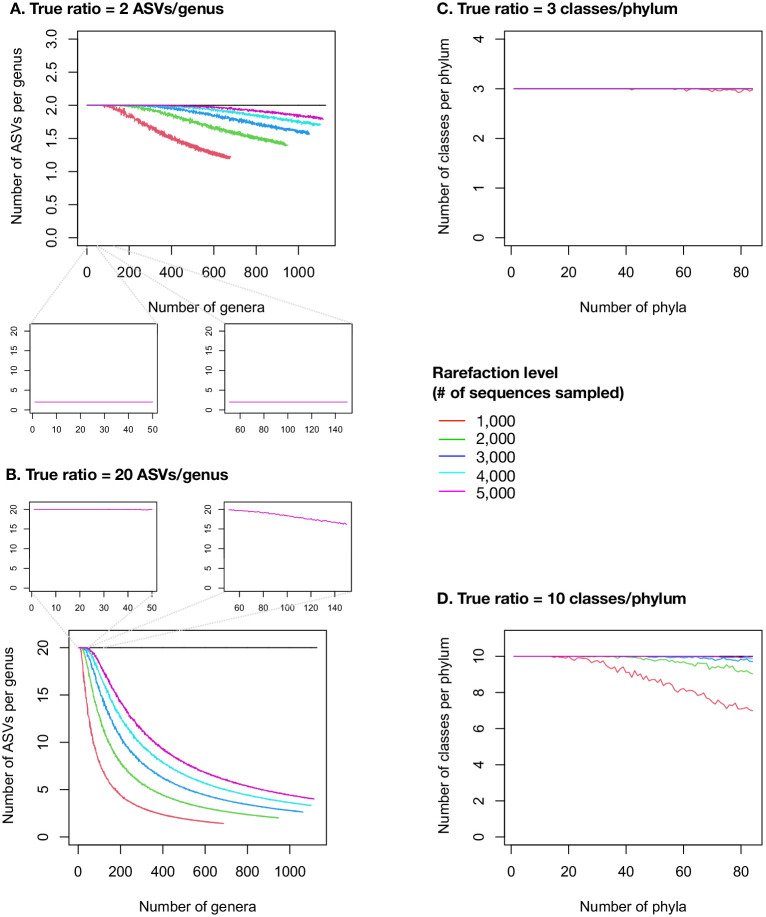
Taxonomic ratios estimated from simulated rarefied sequence data.Each panel simulates a set of microbiome samples that differ in their diversity (number of genera in left panels A and B, number of phyla in right panels C and D) while maintaining a set true taxonomic ratio (horizontal black line). (A) True ratio set to 2 ASVs/genus, close to the per-sample mean and median in the real EMP data, in a range of samples between 1 and 1128 named genera, as observed in the real EMP data. (B) True ratio set to 20 ASVs/genus, equal to the overall mean of 22,014 named ASVs in 1128 named genera, and close to the maximum ratios observed in individual samples (Figure 2—figure supplement 5). Insets show the ranges of 1–50 and 51–150 genera, approximating observations from lower- or higher-diversity samples such as gut and soil, respectively (Figure 2—figure supplement 5). The insets only show the rarefaction to 5000 sequences, as used in the real EMP dataset. (C) True ratio set to three classes/phylum, close to the per-sample mean and median in the real EMP data, in a range of samples between 1 and 84 named phyla, as observed in the real EMP data. (D) True ratio set to 10 classes/phylum, close to the maximum ratios observed in individual samples (Figure 2—figure supplements 2–4). Different rarefaction levels are shown as different coloured lines.